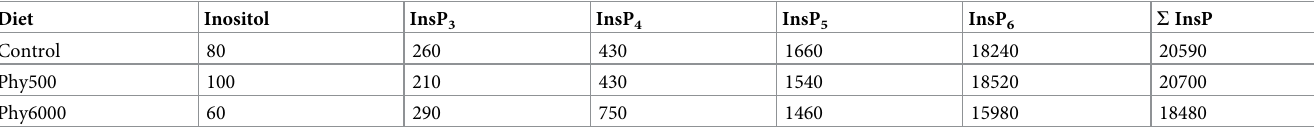
Table 2. Measured inositol and inositol phosphate levels of treatment diets a .